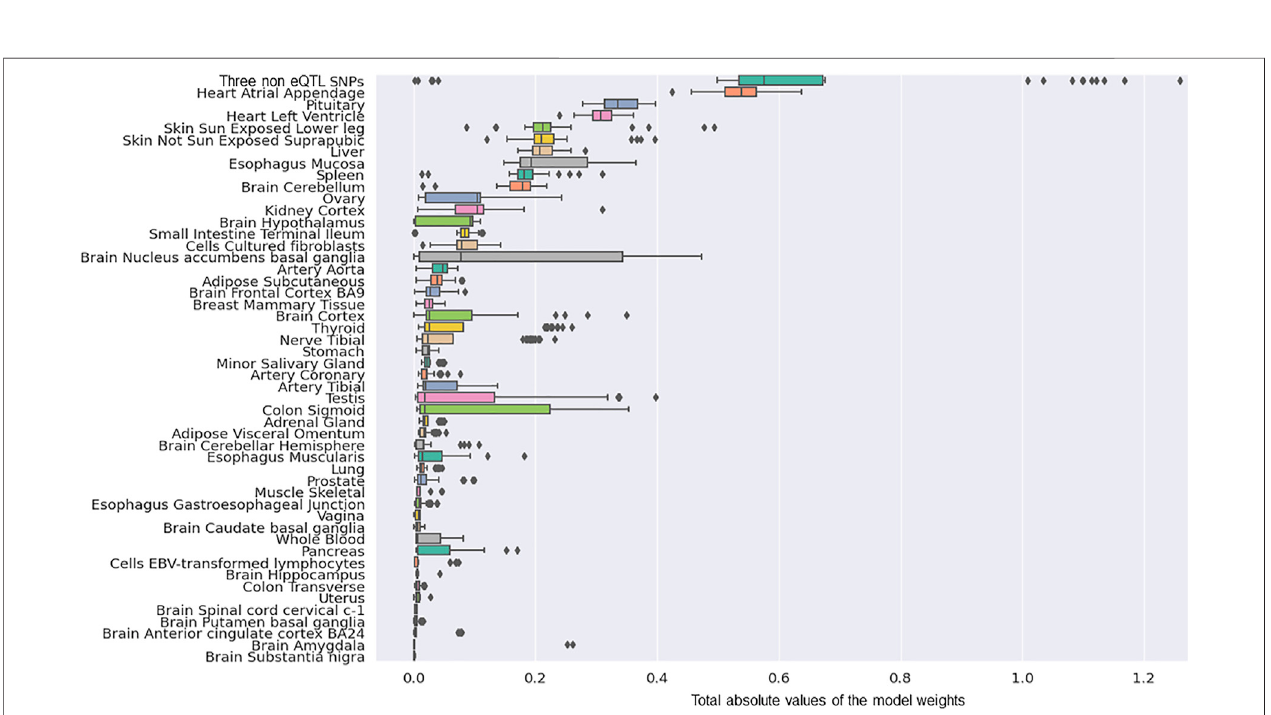
FIGURE 4 | The group contributions of 50 predictors created with model 2 hyperparameters by fi ve repeats of 10 fold cross-validation.